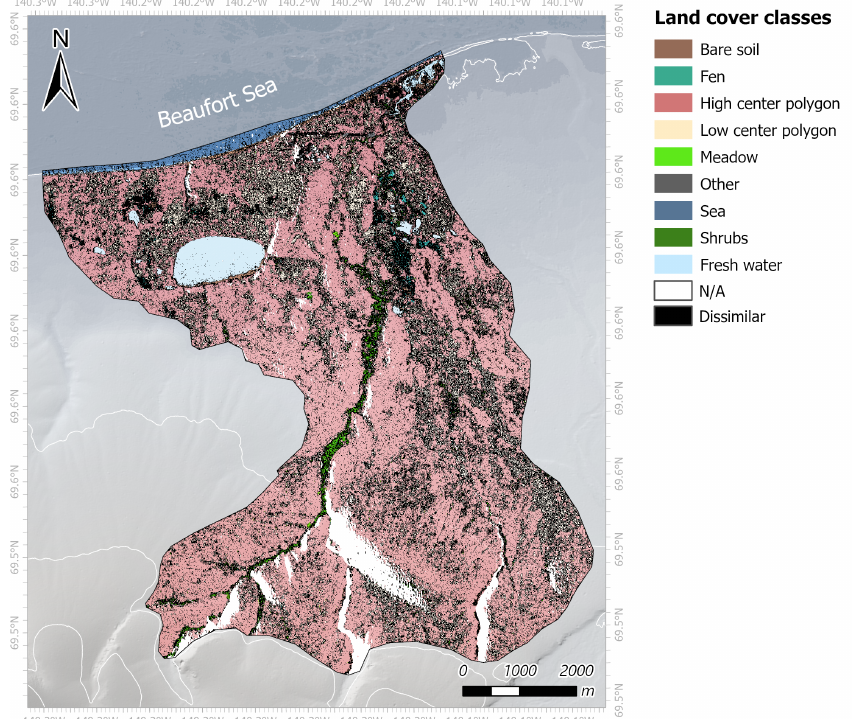
Figure 7. The difference map of the Sigma Nought, SN C1, and the Kennaugh element, KE C1, and classification schemes (Table 4). Black pixels indicate disagreement (36%) and class color-coded pixels indicate agreement (64%). DEM(s) courtesy of the Polar Geospatial Center